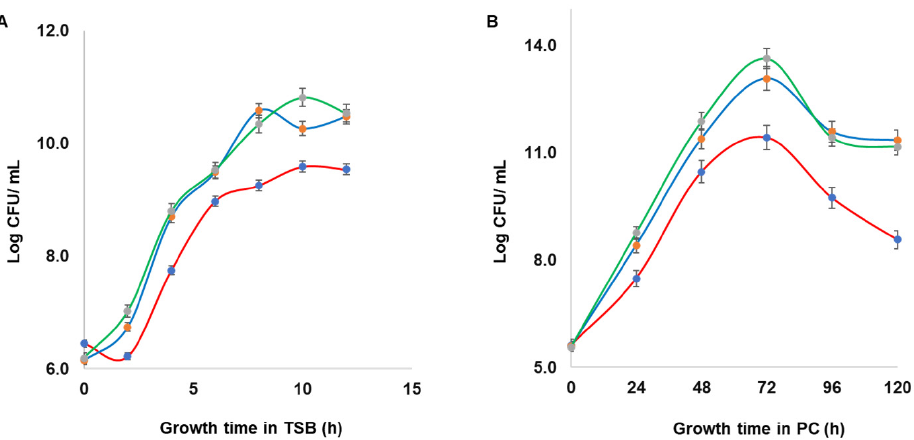
Figure 4. Growth curve analyses of S. aureus CBS2016-05 wild type and derivative enterotoxin mutant strains. The bacterial strains were grown in ( A ) trypticase soy broth (TSB) at 37 ◦ C with agitation, and ( B ) platelet concentrates (PCs) incubated 20 ± 2 ◦ C under agitation. N = 3; error bars represent standard deviation based on three replicates.